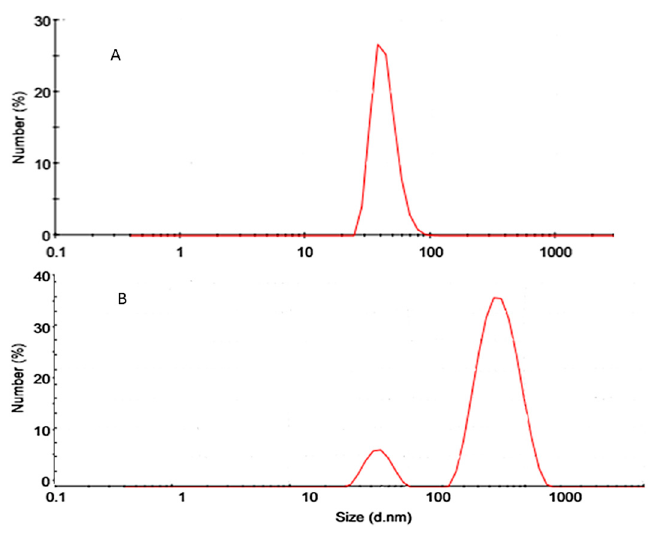
Figure 4. Particle size distribution ( A ) for the selected SNEDDS ( B ) for the extract-loaded SNESNS. Transmission Electron Microscopy (TEM)